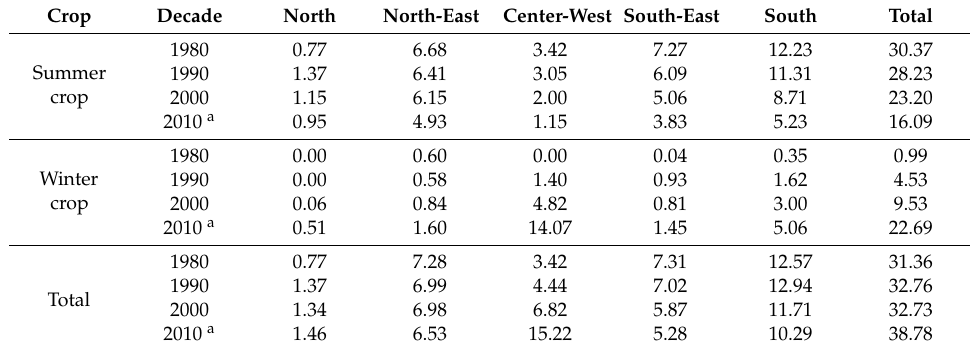
Table 2. Brazilian corn planted area (annual average) by regions between 1980s and 2010s (million acres). Crop